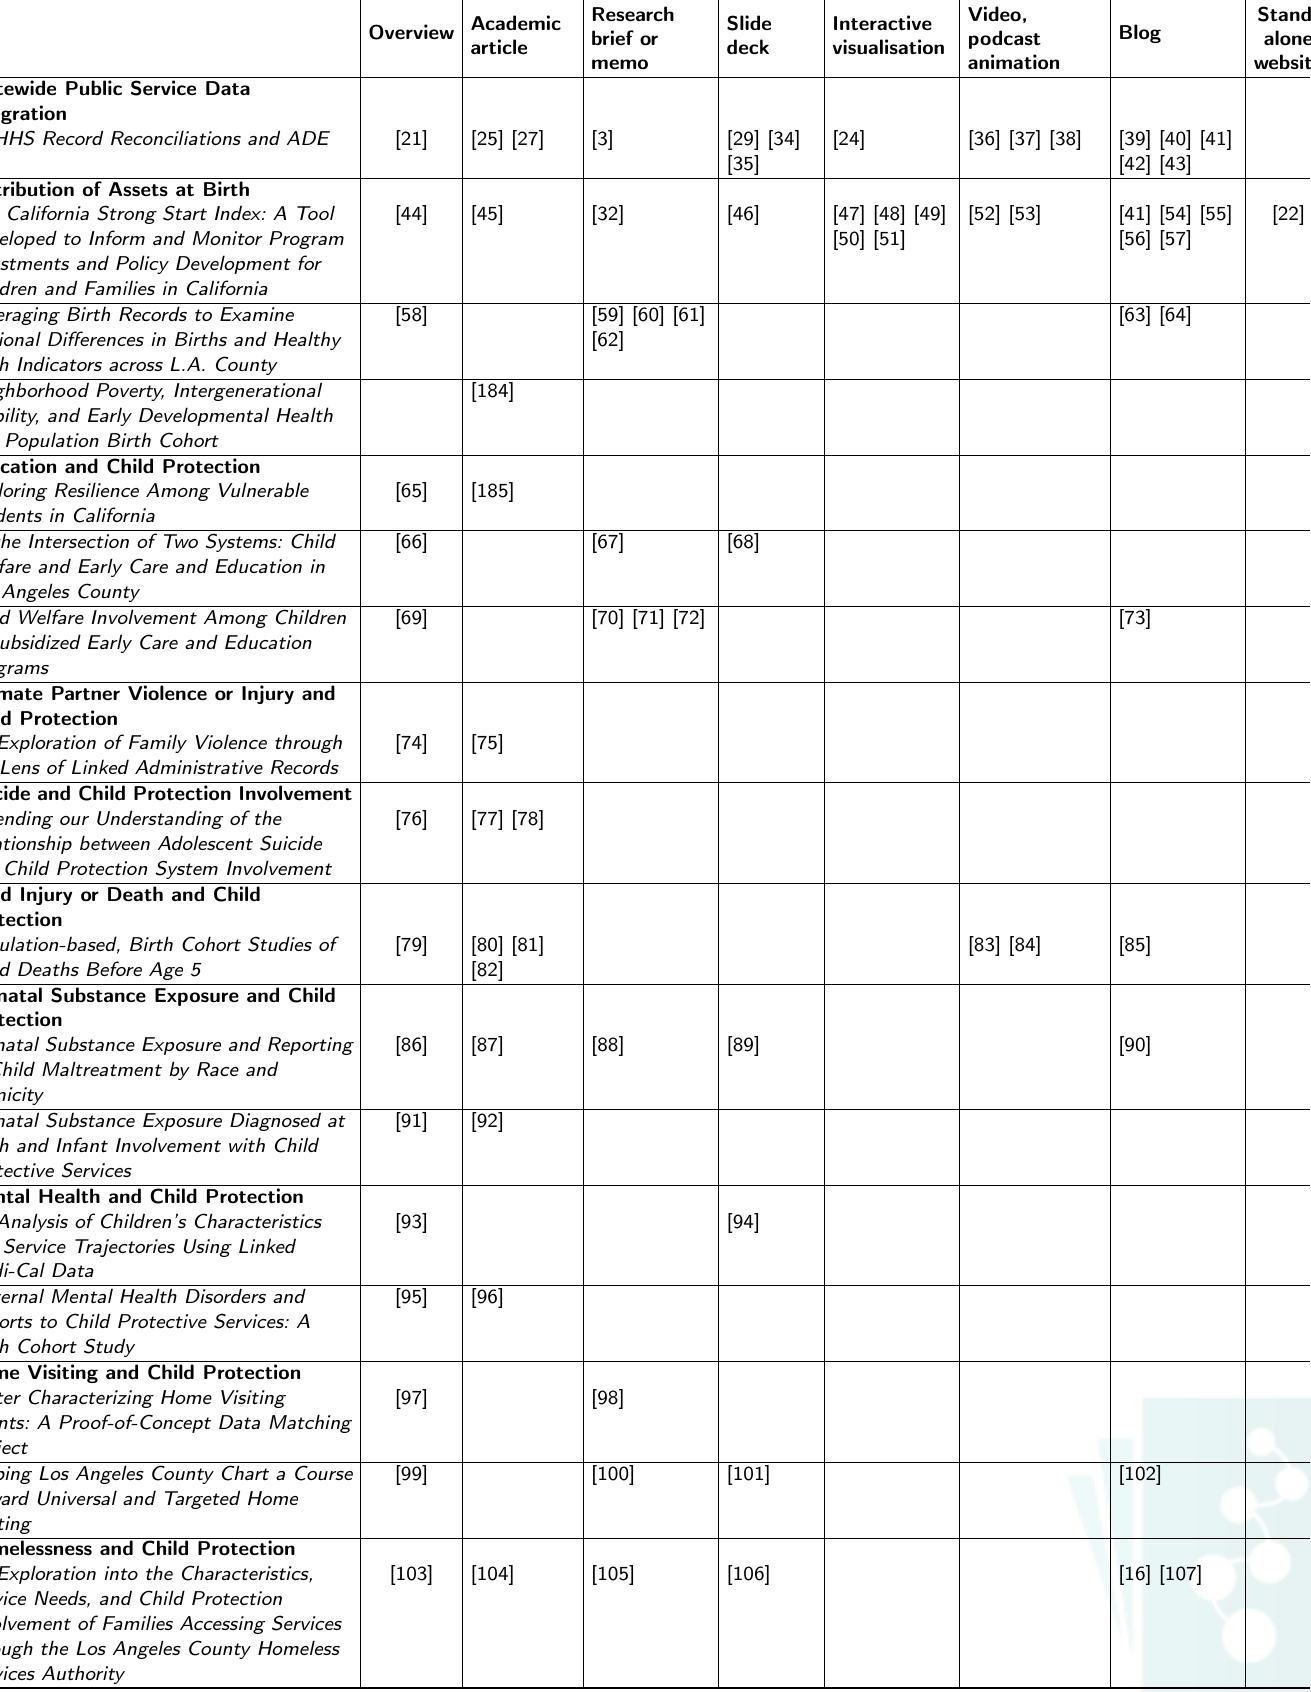
Table 3: Children’s Data Network projects, by content area and product